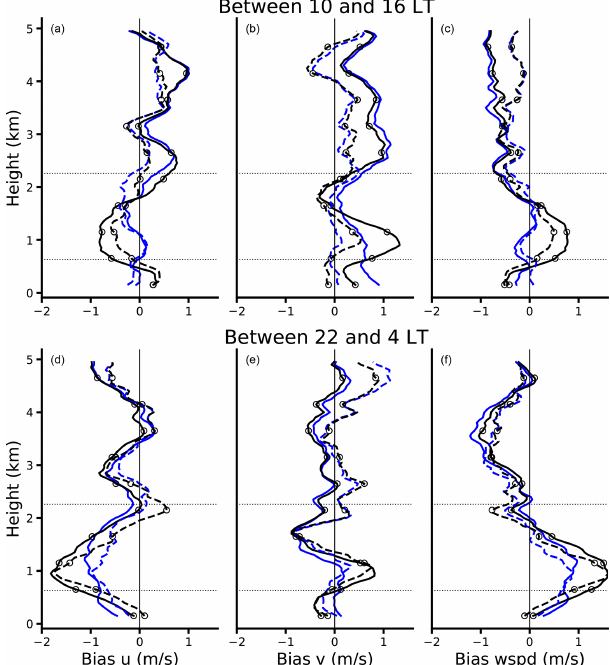
Figure 14. Mean IFS bias (forecast in solid and analysis in dashed) during EUREC 4 A with respect to radiosondes. Blue refers to the control experiment, while black circles refer to the experiment with convective momentum transport turned off (Exp3). The top (a–c) and bottom rows (d–f) respectively show the bias between 10:00 and 16:00LT and between 22:00 and 04:00LT.